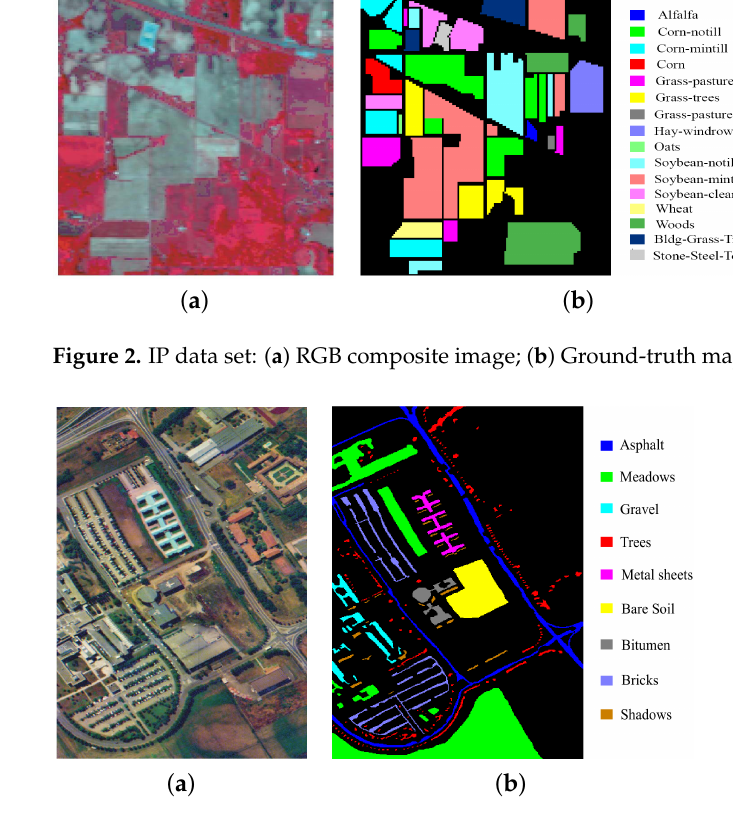
Figure 3. UP data set: ( a ) RGB composite image; ( b ) Ground-truth map.